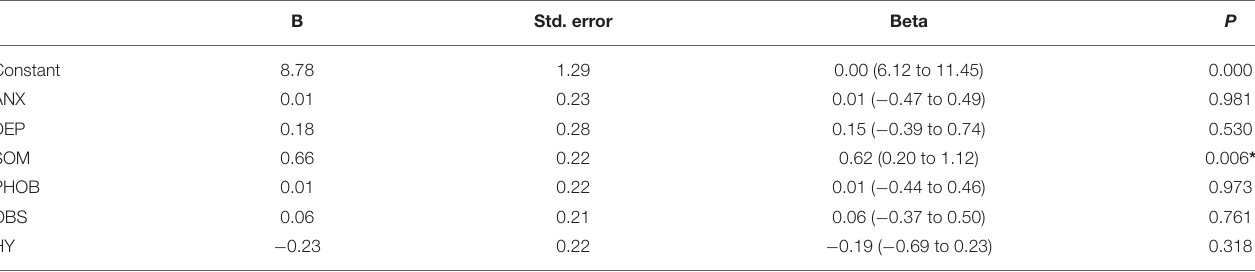
TABLE 3 | Linear model of predictors ANX, DEP, SOM, PHOB, OBS, HY of “Fear of Covid-19” with 95% bias corrected and accelerated confidence intervals reported in parentheses.